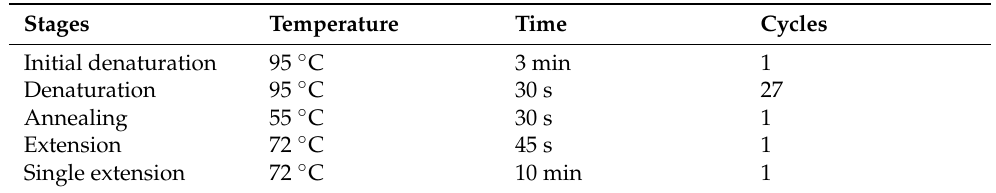
Table A2. PCR amplification of 16S rRNA gene.